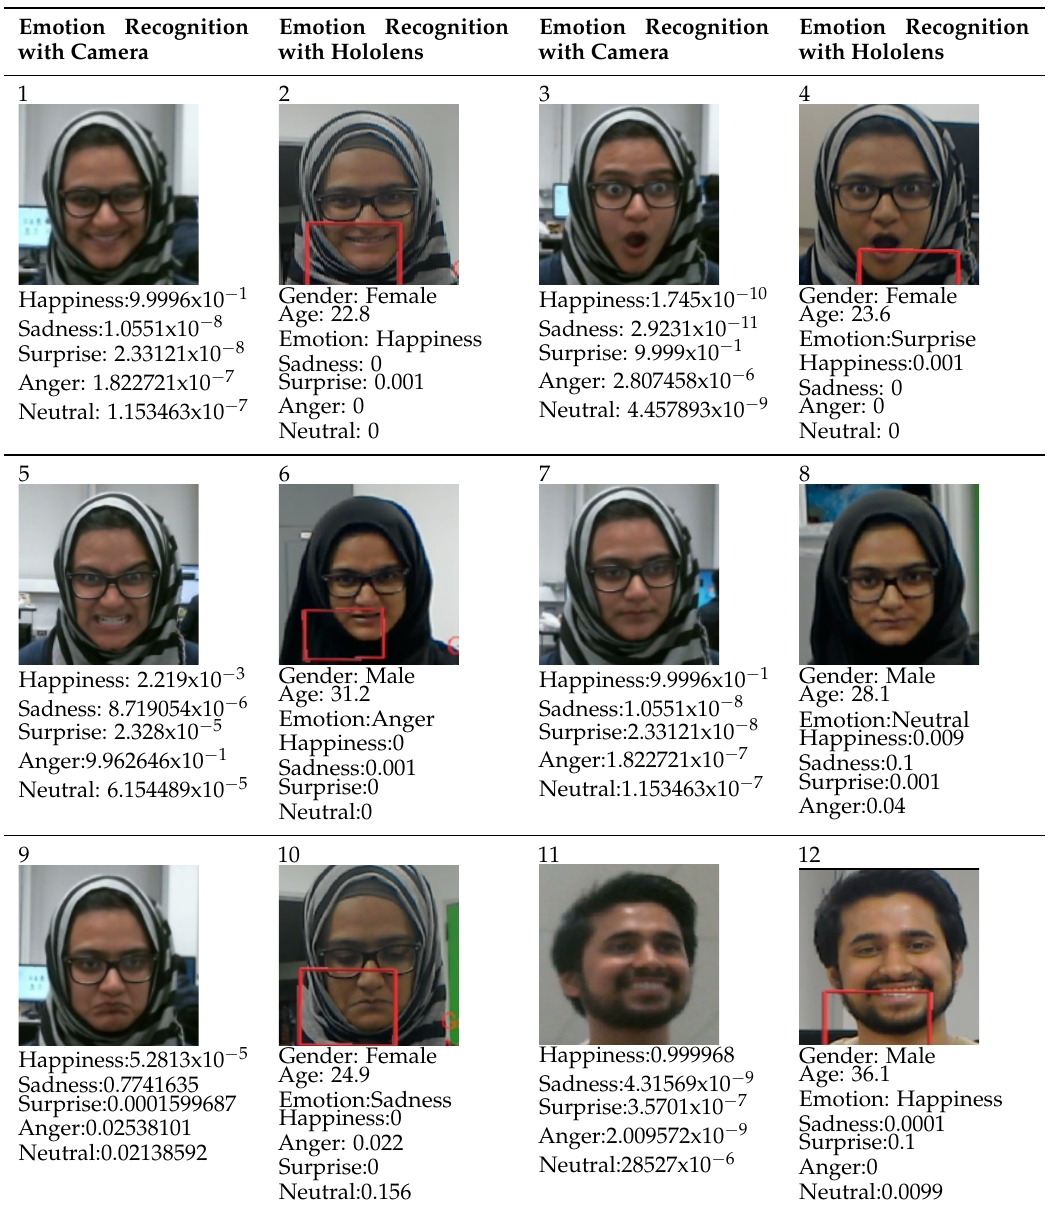
Table 2. Comparison of emotion recognition using the HoloLens and a